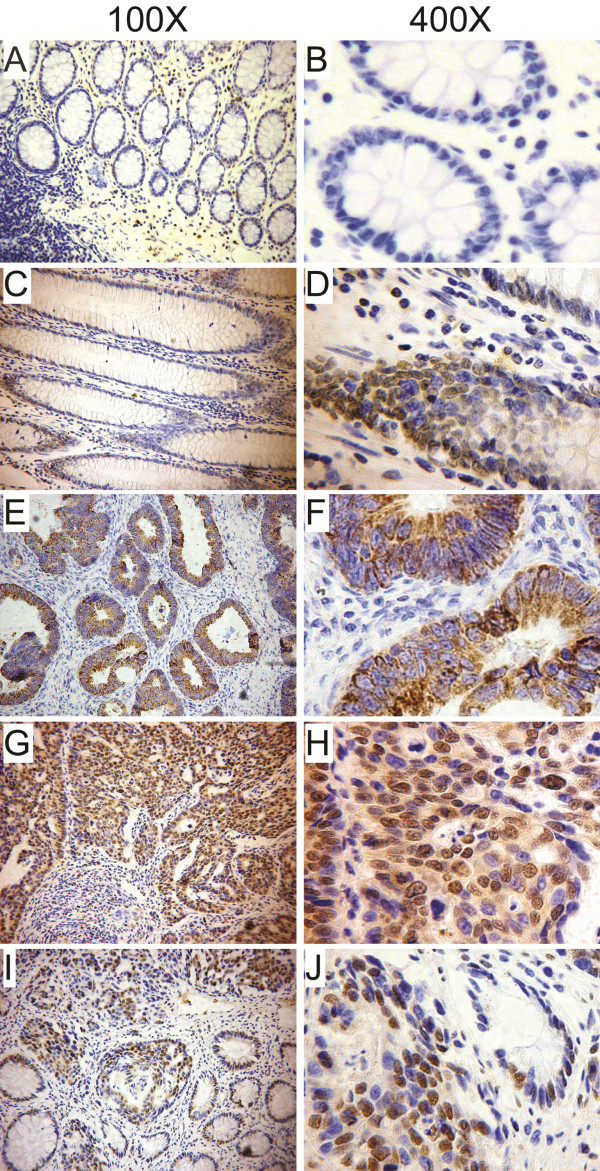
Representative images of Sam68 immunohistochemical analysis in colorectal cancer (CRC) tissues. (A – D) Negative (A, 100X; B, 400X) or moderate (C, 100X; D, 400X) Sam68 staining was detected in the adjacent non-cancerous tissues. (E – H) Cytoplasmic Sam68 staining (E, 100X; F, 400X) or nuclear Sam68 staining (G, 100X; H, 400X) was observed in primary CRC tissues. (I – J) Sam68 was upregulated in CRC compared to the paired adjacent non-cancerous tissues (I, 100X; J, 400X).